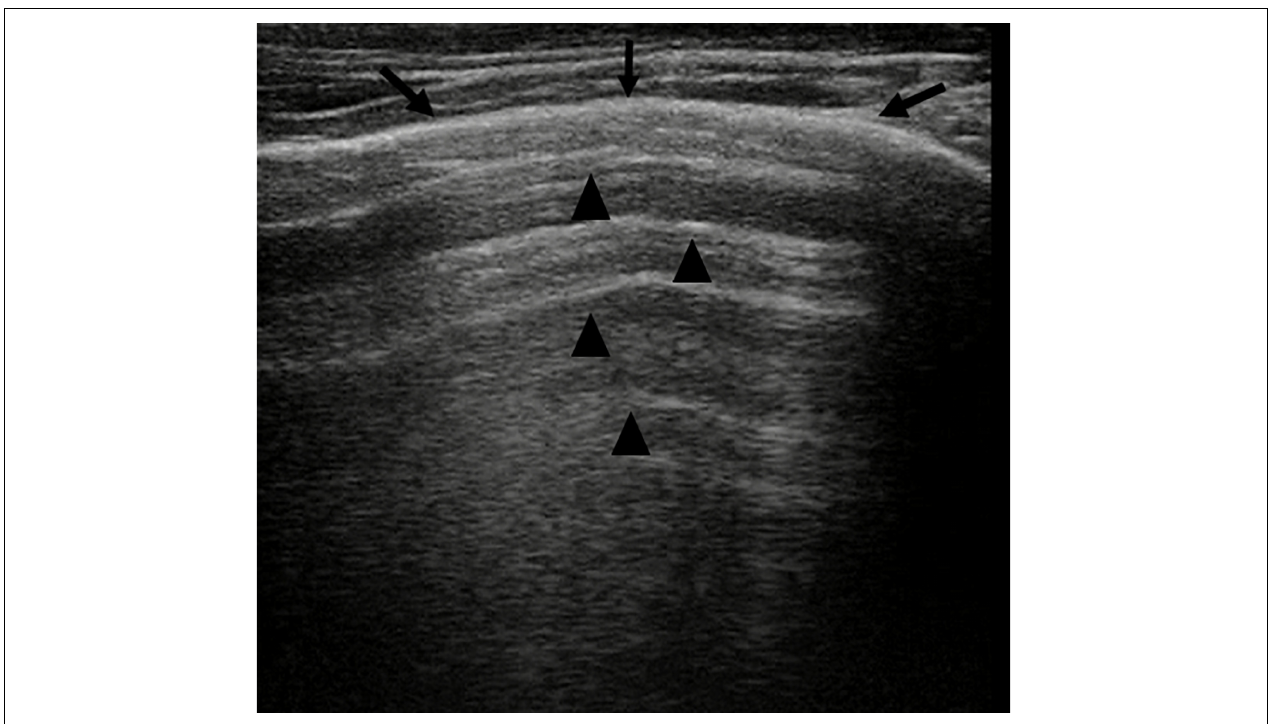
FIGURE 1 | Grayscale lung ultrasound examination (transverse scan between intercostal fields; linear probe with 12 MHz frequency) shows a normal lung ultrasound pattern: hyperechoic, regular, and smooth pleural line with a thickness of less than 0.5 mm ( arrows ), pleural sliding present, and normally represented characterized by “to and fro” movement of lung surface synchronized with respiration ( Electronic Supplementary Video 1 ). Below the pleural line, lung ultrasound imagines show A-lines ( arrowheads ): echogenic horizontal lines parallel and equidistant from each other which indicate the presence of normally aerated